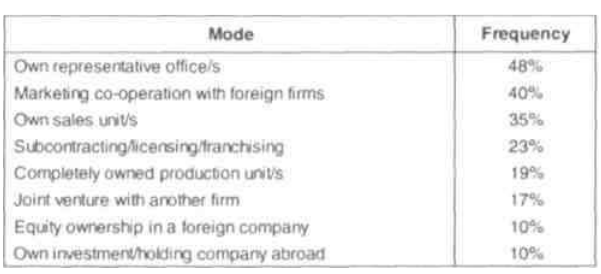
Table 10. The Operations of the Baltic